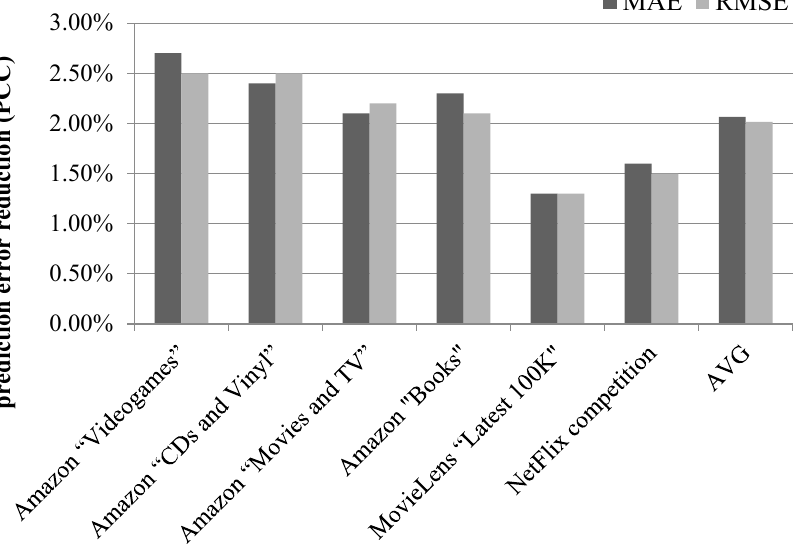
Figure 2. MAE and RMSE reduction achieved by the proposed algorithm, when using the PCC user similarity metric. The proposed algorithm achieves an average prediction MAE reduction of 2.1% and an average prediction RMSE reduction of 2.0%, when using the PCC user similarity met- ric. Examining each dataset individually, the performance edge of the proposed algorithm against the plain CF algorithm ranges from 1.3% and 1.3% (for the MovieLens 100K da- taset) to 2.7% and 2.5% (for the Amazon “Videogames” dataset), for the MAE and the RMSE metrics, respectively.